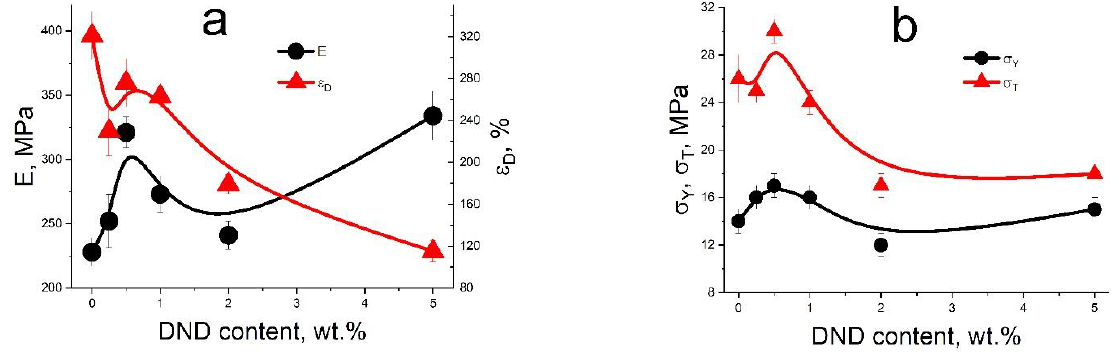
Figure 4. Mechanical properties of the compositional Aquivion ® -type membranes (EW = 890 g- eq/mol): ( a ) Young’s modulus E and ultimate deformation before destruction ε D , and ( b ) yield strength σ Y and ultimate tensile strength σ T .